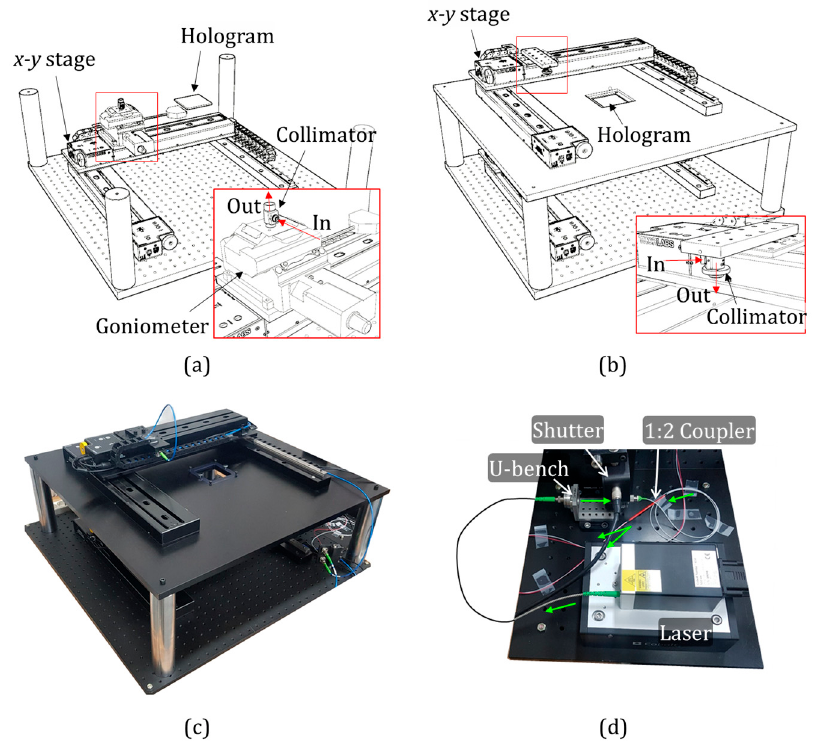
Figure 3. The hologram printer used to generate the HOE for the IHP. Designs of ( a ) signal arm and ( b ) reference arm. Photos of ( c ) the hologram printer and ( d ) light source parts of the realized